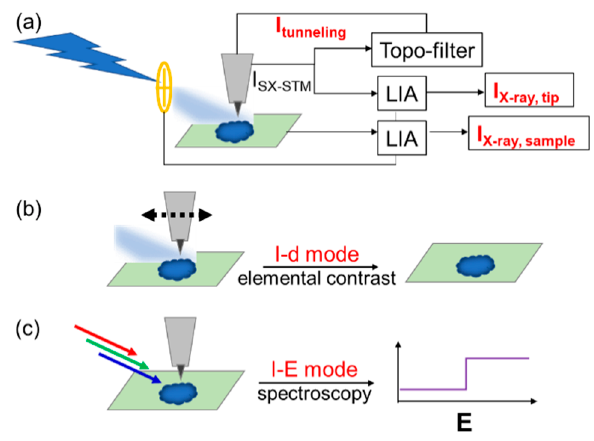
Figure 2. Schematic of an SX-STM experiment ( a ); SX-STM modes and their expected results ( b ) I-d mode and ( c ) I-E mode.